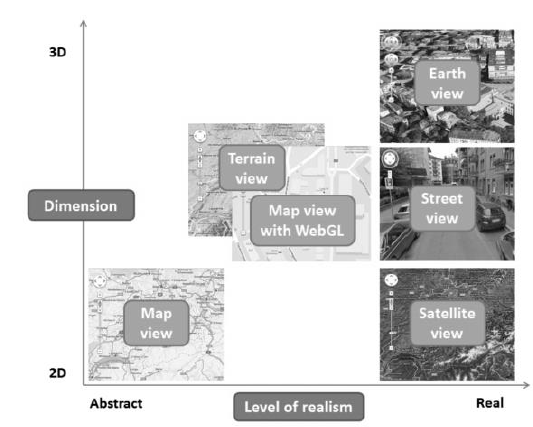
Figure 1. A rough classification of an example set of popularly used geovisualization types (Boér et al., 2013).